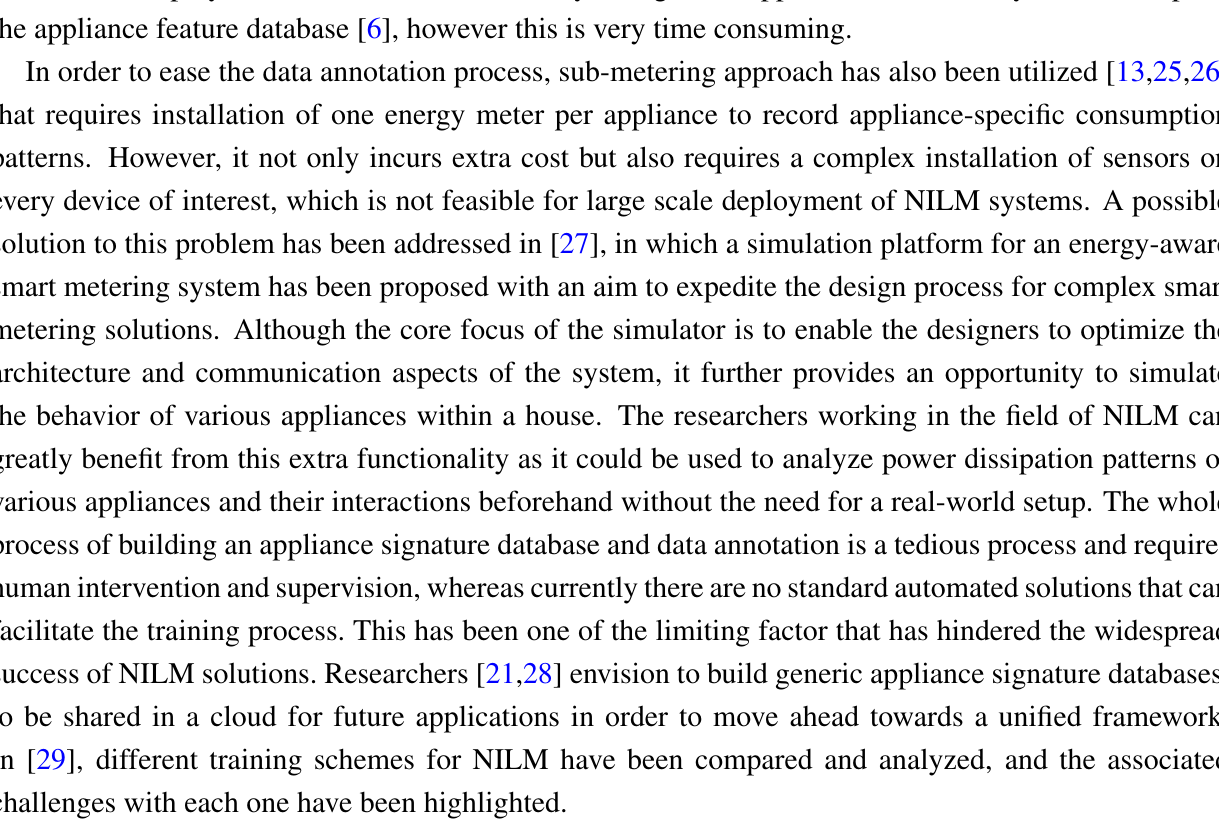
Figure 2. Taxonomy of appliance features for energy